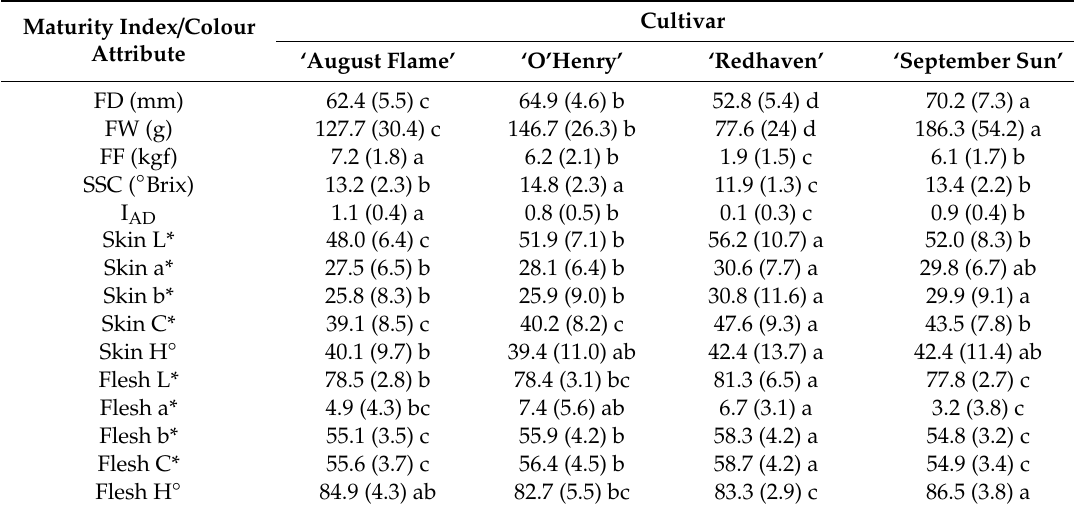
Table 2. Fruit diameter (FD), fruit weight (FW), flesh firmness (FF), soluble solids concentration (SSC), I AD and skin and flesh colour attributes (L*, a*, b*, C*, H ◦ ) in fruit of four yellow peach cultivars at harvest ( n = 200). Medians and standard deviations (in brackets) are presented. Di ff erent letters represent significant di ff erences ( p < 0.01) between cultivars based on analysis of variance (ANOVA) followed by the Games–Howell post hoc